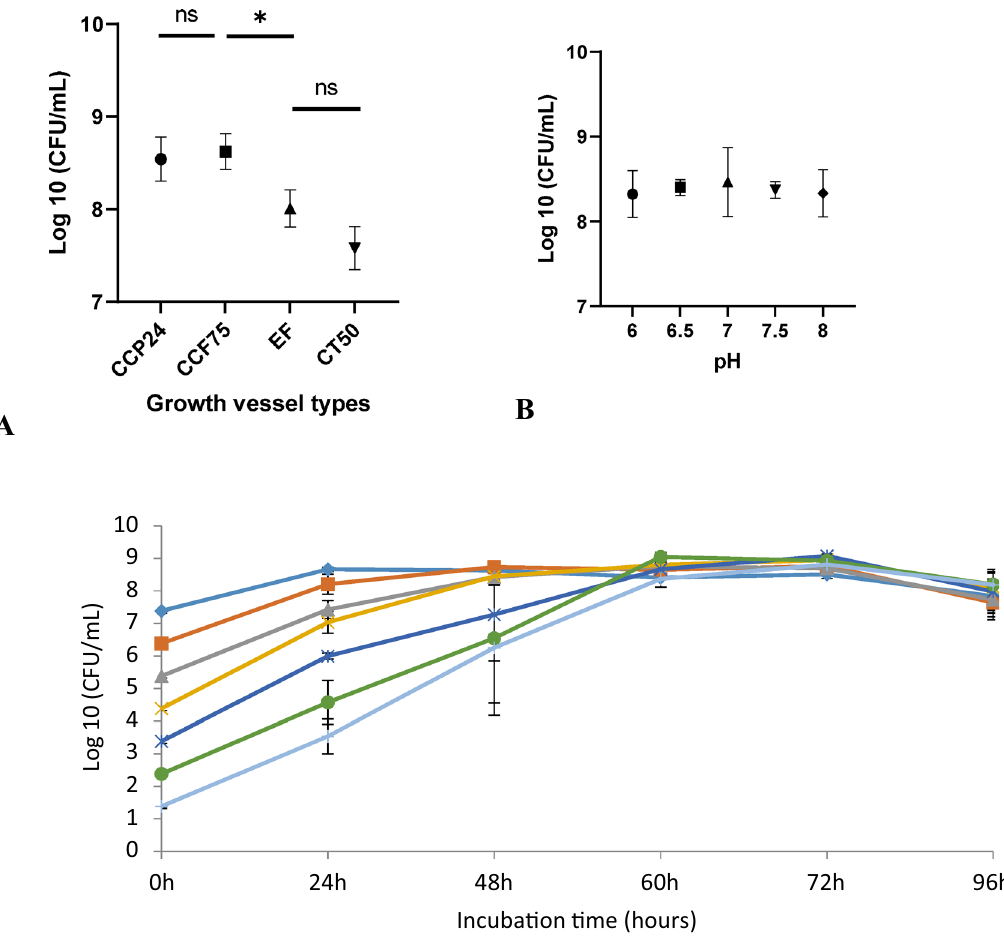
Figure 2. (A) Effect of growth vessel type on the growth of C. hepaticus HV10 T . CCP24 24 well cell culture flask, TCF75 tissue culture flask 75cm 2 , EF Erlenmeyer flask, CT50 corning 50 mL tube. (B) Growth of